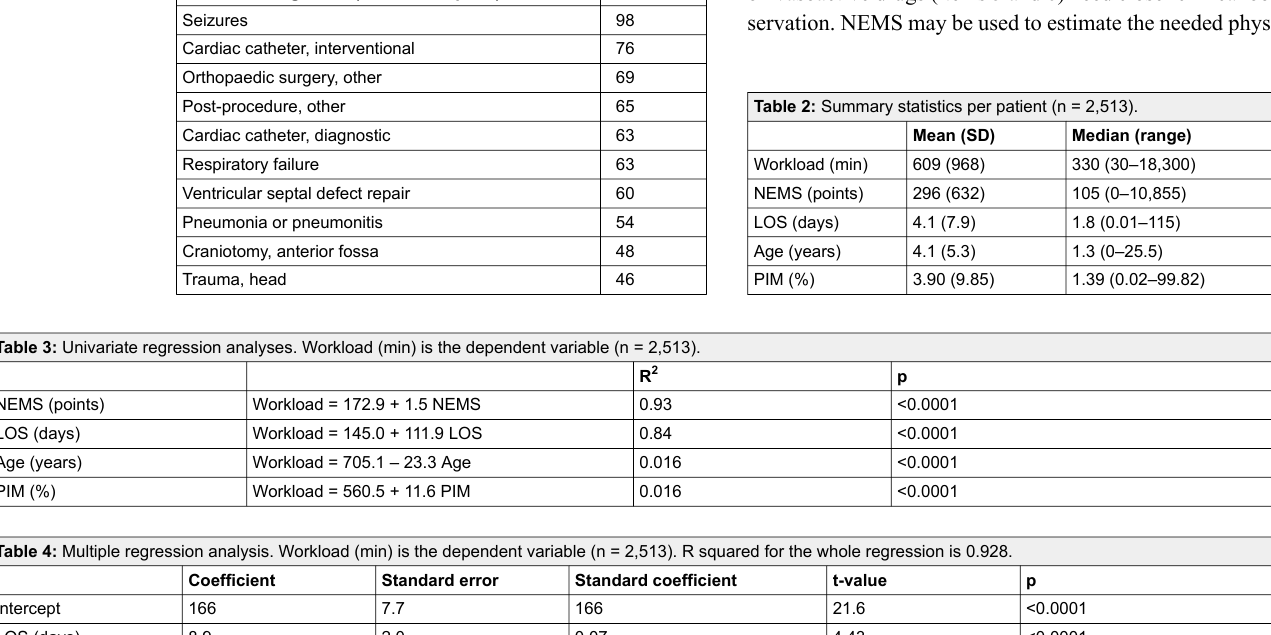
Table 2: Summary statistics per patient (n = 2,513).